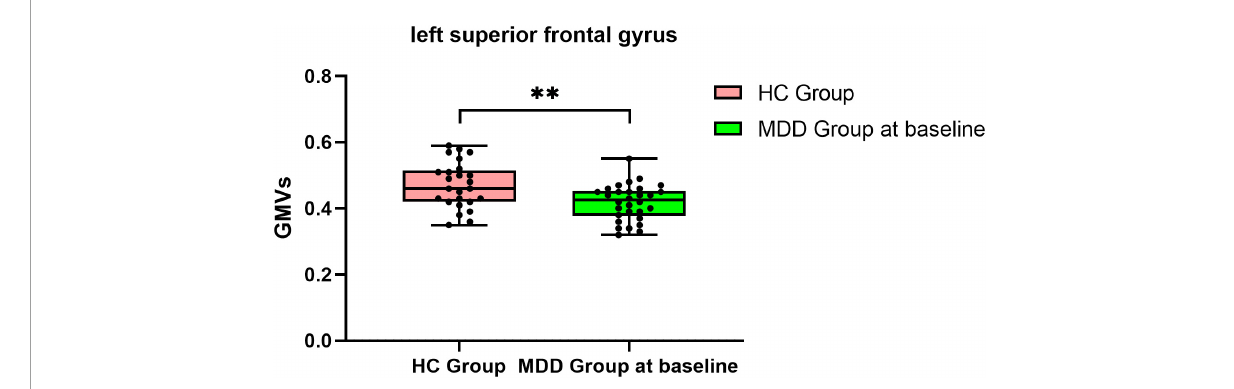
FIGURE2 Bar graph showing decreased GMVs in the left superior frontal gyrus in MDDs compared with HCs, ∗∗ p < 0.01.